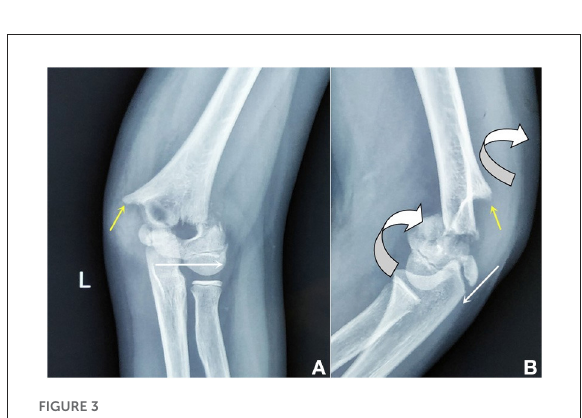
FIGURE3 In the AP view (A) , the distal fragment (white arrow) was anterior-lateral translocation. In the lateral view (B) , the distal fragment was obviously rotation both on X - and Y -axes (rotation arrow), and the proximal fragment spike was obvious (yellow